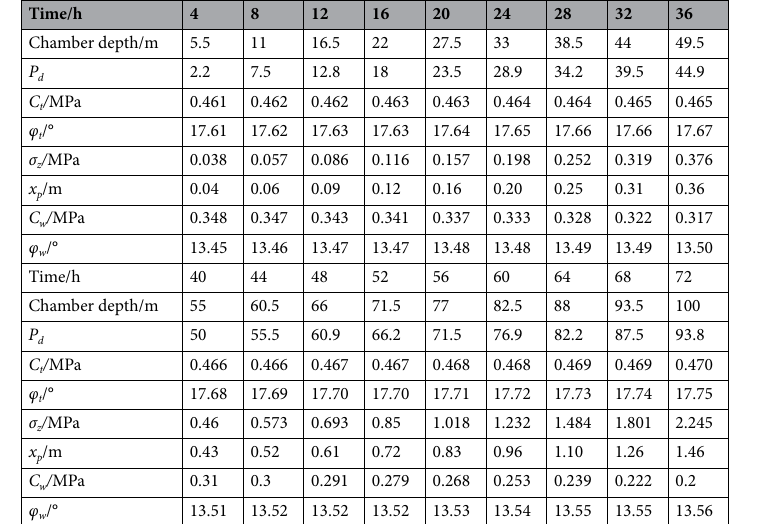
Table 8. Slice width distribution pattern and evolution weak layer parameters of a 6.6-m-wide coal pillar.